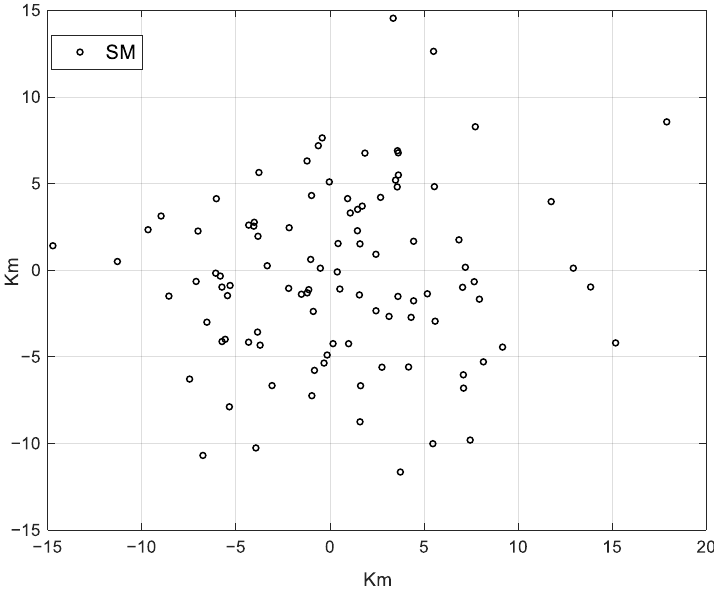
Figure 5. The result of SMs’ distribution .